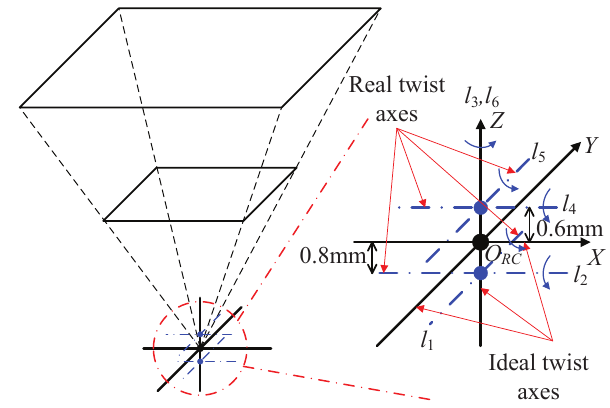
Figure 6. Illustration for real twist axes and ideal twist axes.